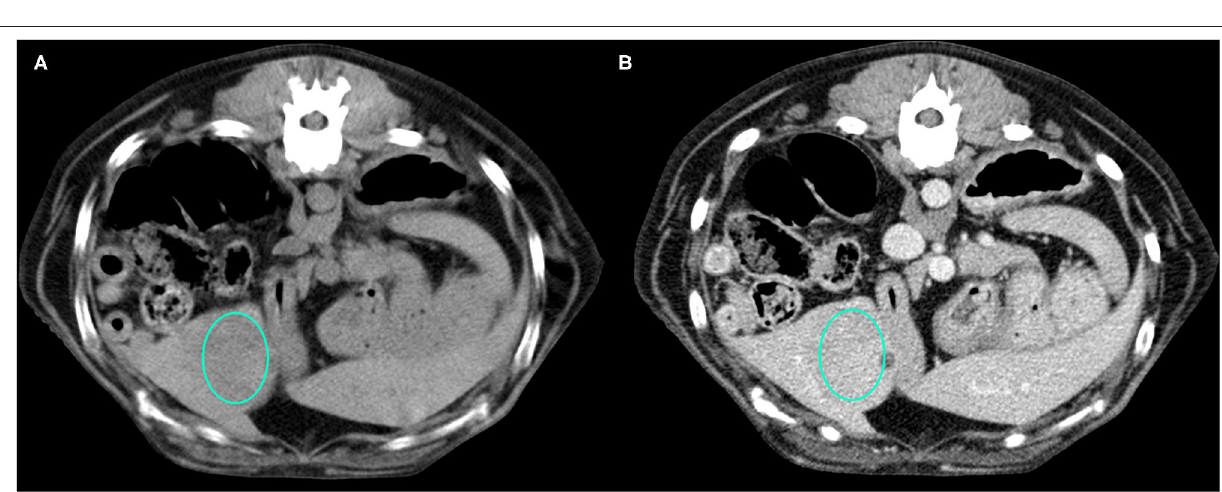
FIGURE 2 | Example of an OBL lesion (diagnosed as adenoma) showing hyperattenuation and hypoenhancement, diffuse contrast enhancement pattern, with homogeneous distribution, well-defined margins, regular surface, and cyst-like appearance. (A) image obtained from the pre-contrast scan; (B) image obtained from the delayed scan. A ROI is placed inside the lesion in both. Based on the developed decision tree this lesion was classified as